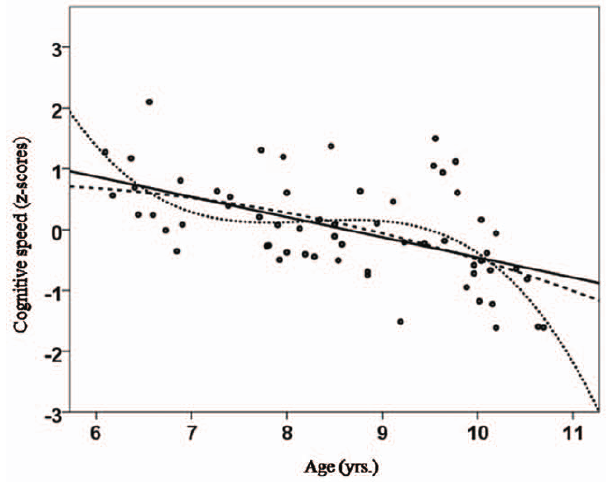
Figure 1. Correlation between age (yrs.) and cognitive speed as assessed by the KITAP (z-scores) [ 18,33 ] . A linear trend indicated a reduction in cognitive speed with increasing age, a quadratic trend indicated a sudden decrease in cognitive speed at the age of 10 years, and a cubic trend was indicative of a stepwise decrease in cognitive speed (decrease – plateau – decrease) for the age range of 6 to 10 years.